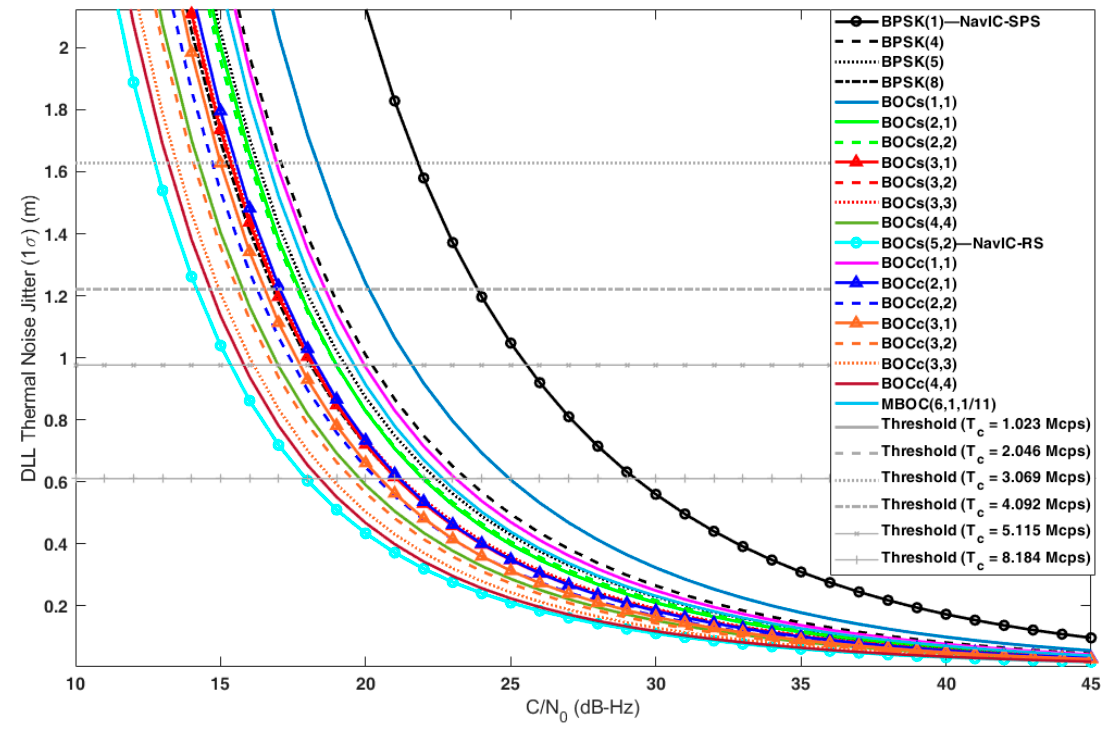
Figure 3. The DLL errors and stability thresholds of the candidates.